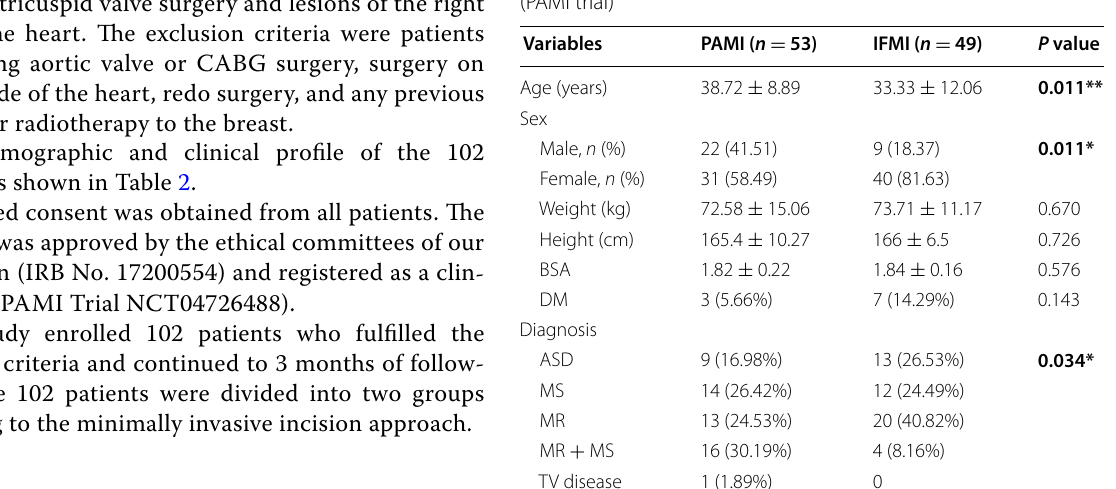
Table 2 Demographic details of our randomized controlled